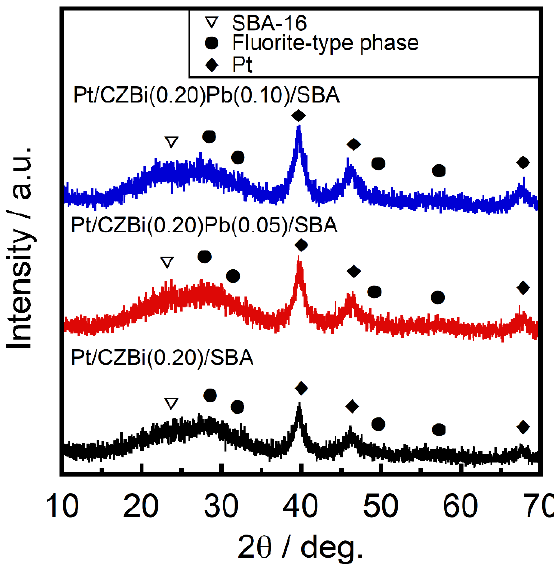
Figure 2. XRD patterns of Pt/CZBi(0.20)Pb( x )/SBA. The effect of introducing Pb 2+/4+ on oxygen release and storage abilities was investi- gated using temperature-programmed reduction (TPR) measurements. The TPR profiles of CZBi(0.20)Pb( x )/SBA are shown in Figure 3. The Pb 2+/4+ introduction lowered the reduc- tion temperature, and CZBi(0.20)Pb(0.05)/SBA showed the lowest peak temperature among CZBi(0.20)Pb( x )/SBA. In addition, the total oxygen storage capacity of CZBi(0.20)Pb(0.05)/SBA was the highest (243 µ mol · g − 1 ), followed by CZBi(0.20)Pb(0.10)/SBA (237 µ mol · g − 1 ) and CZBi(0.20)/SBA (236 µ mol · g − 1 ). Therefore, CZBi(0.20)Pb(0.05)/SBA exhibited the highest oxygen release and storage abilities owing to the synergistic redox reaction between Ce 3+/4+ and Pb 2+/4+ . Further, the decrease in the abilities of CZBi(0.20)Pb(0.10)/SBA might be caused by the decrease in its surface area.